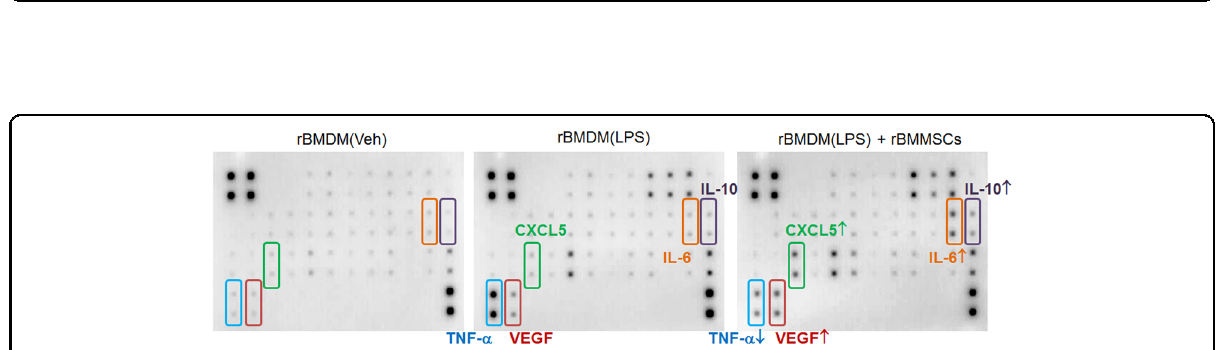
Fig. 1 Expression of in fl ammation-related mediators in rBMDMs is altered by coculture with rBMMSCs. a The mRNA levels of factors such as iNOS, IL-1 β , TNF- α , and Arg1 were assessed in LPS-stimulated BMDMs with or without rBMMSC coculture. b The mRNA levels of factors such as Arg1, CD206, and IL-10 were assessed in IL-4/IL-13-treated BMDMs with or without rBMMSC coculture. c The iNOS mRNA to Arg1 mRNA ratio was calculated to show the skewed macrophage polarization toward the anti-in fl ammatory phenotype. The Arg1 and iNOS protein expression patterns in LPS-stimulated rBMDMs ( d ) or IL-4/IL-13-treated rBMDMs ( e ) with or without rBMMSC coculture. rBMDMs Rat bone marrow-derived macrophages; rBMMSCs Rat bone marrow-derived mesenchymal stem